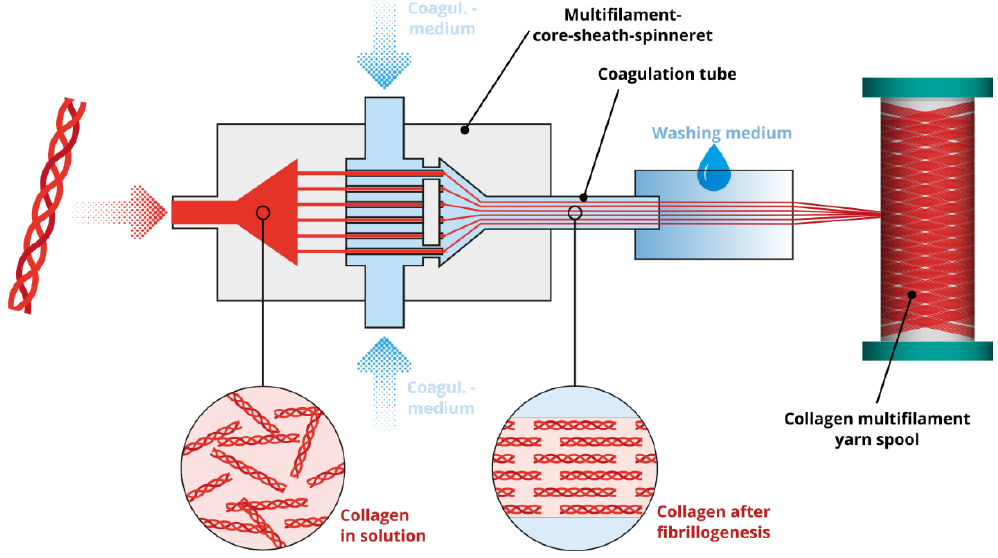
Figure 7. Schematic representation collagen wet spinning with a multifilament-core-sheath-spinneret.